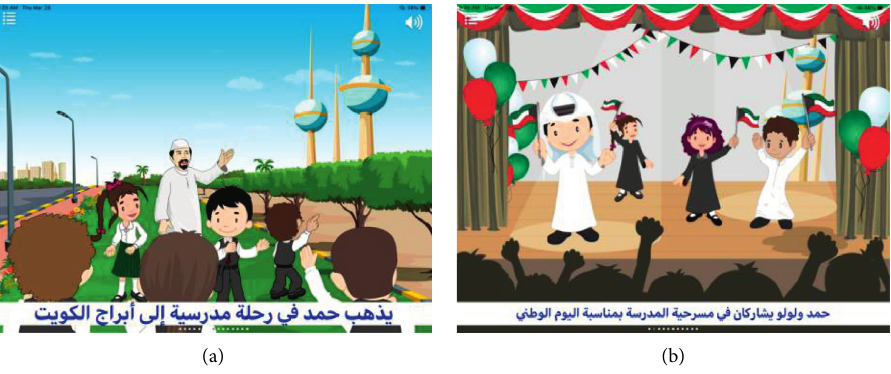
Figure 2: eStories reflecting local culture.